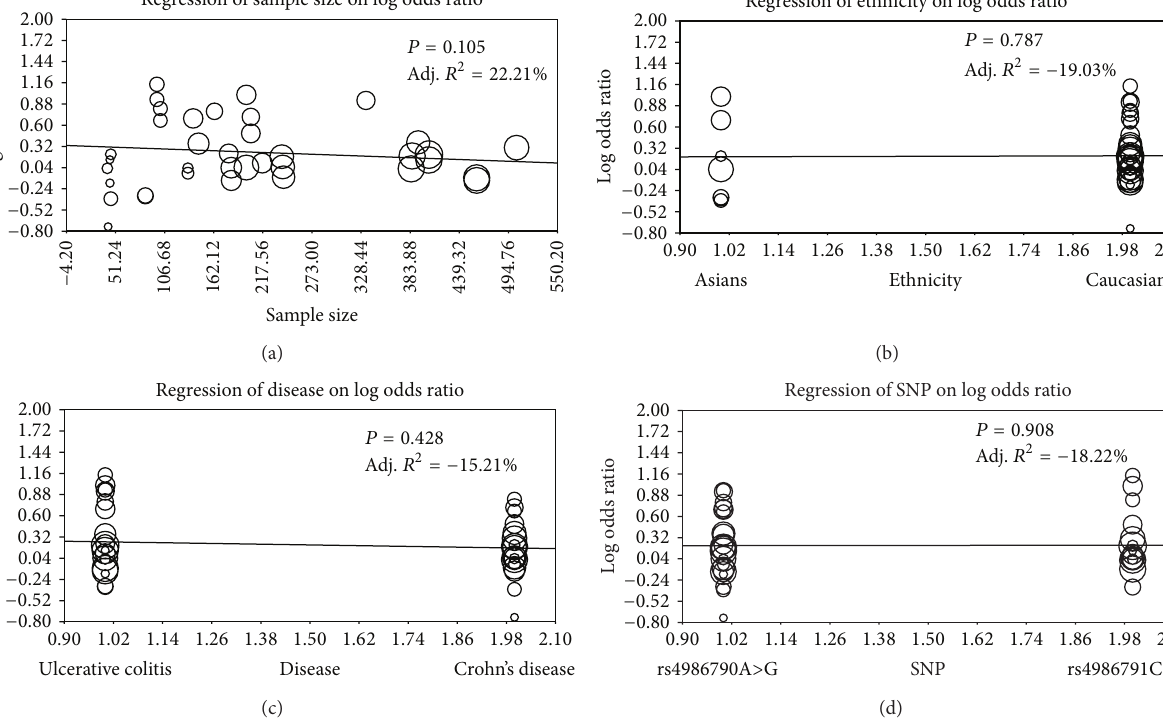
pattern of TLR4 SNPs in Iranian population compared